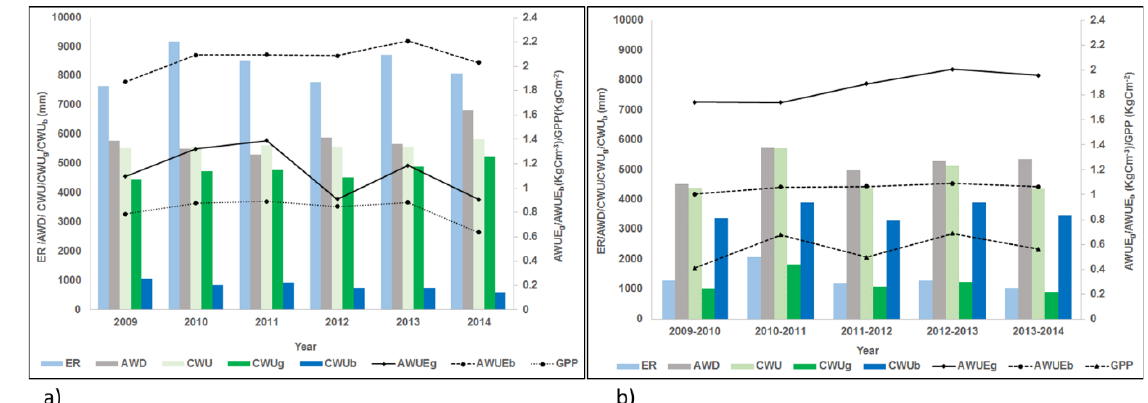
Figure 4: Temporal variability of green and blue water use efficiency (2009-2014), a) kharif season; b)rabi